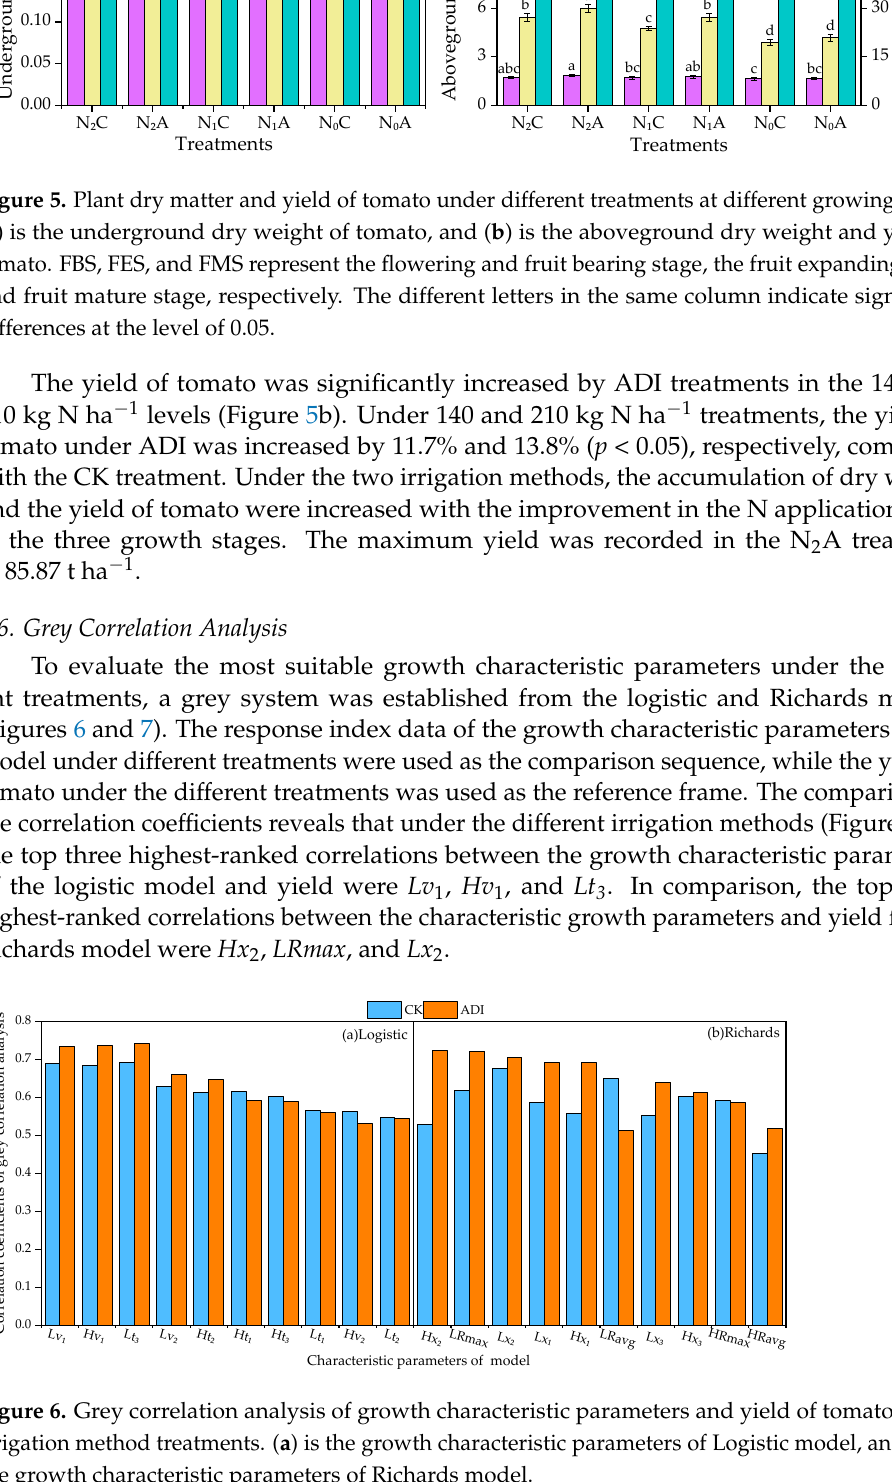
Figure 5. Plant dry matter and yield of tomato under different treatments at different growing stages. ( a ) is the underground dry weight of tomato, and ( b ) is the aboveground dry weight and yield of tomato. FBS, FES, and FMS represent the flowering and fruit bearing stage, the fruit ex- panding stage, and fruit mature stage, respectively. The different letters in the same column indicate significant differences at the level of 0.05.